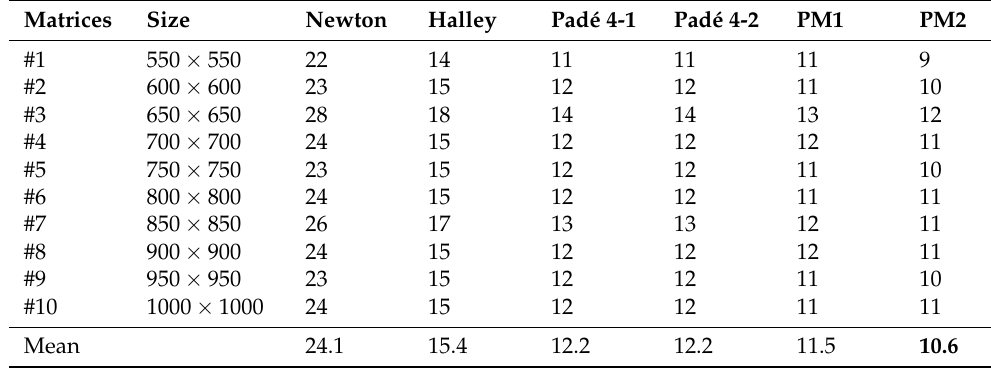
Table 1. Results of comparisons via number of iterates for Experiment 1.